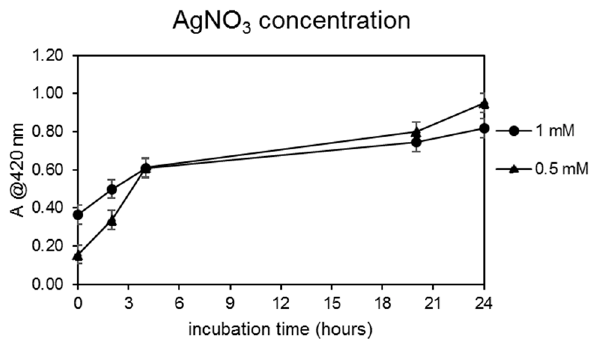
Figure 4. AgNPs yields’ dependence on the AgNO 3 concentration. Experiments were carried out using the CFS from the SAMU strain (CFS/water ratio of 2/3) at 80 °C and for 24 h of incubation. The formation of silver NPs was monitored by measuring the solutions’ absorbance at 420 nm.